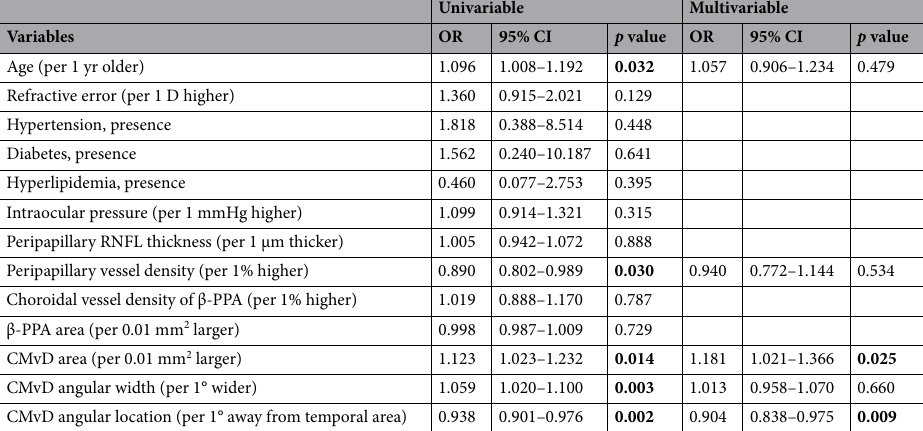
Table 2. Factors associated with the diagnosis of NAION versus NTG. β-PPA β-zone peripapillary atrophy, CI Confidence interval, MvD Choroidal microvasculature dropout, NAION Nonarteritic anterior ischemic optic neuropathy, NTG Normal-tension glaucoma, OR Odds ratio, RNFL Retinal nerve fiber layer. Boldface p values indicate statistical significance.